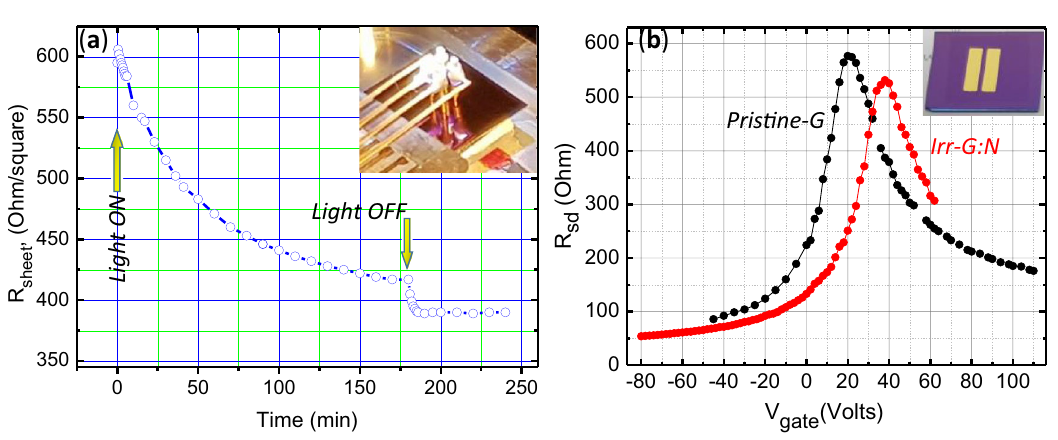
Figure 5. ( a ) Kinetics of sheet resistance change of G:N single layer on SiO 2 /Si substrate submitted to irradiation in air with a Xe-lamp. The sheet resistance stabilizes to its lowest value after about 3 h. The decrease, as soon as the lamp is turned off, is due to the thermal coefficient of the resistance . The inset shows the 4-probe Van der Pauw configuration. ( b ) Plot of the resistance between source and drain (R sd ) as a function of gate voltage (V g ) taken after thermal annealing (T = 200 °C) and in vacuum. The data in red and black are for irradiated graphene:N and pristine graphene, respectively. The inset shows the gold electrodes configuration of the FET device on SiO 2 /Si (channel length = 0.8 mm, width = 8 mm). The size of the single layer graphene:N is about 15 × 15 mm 2